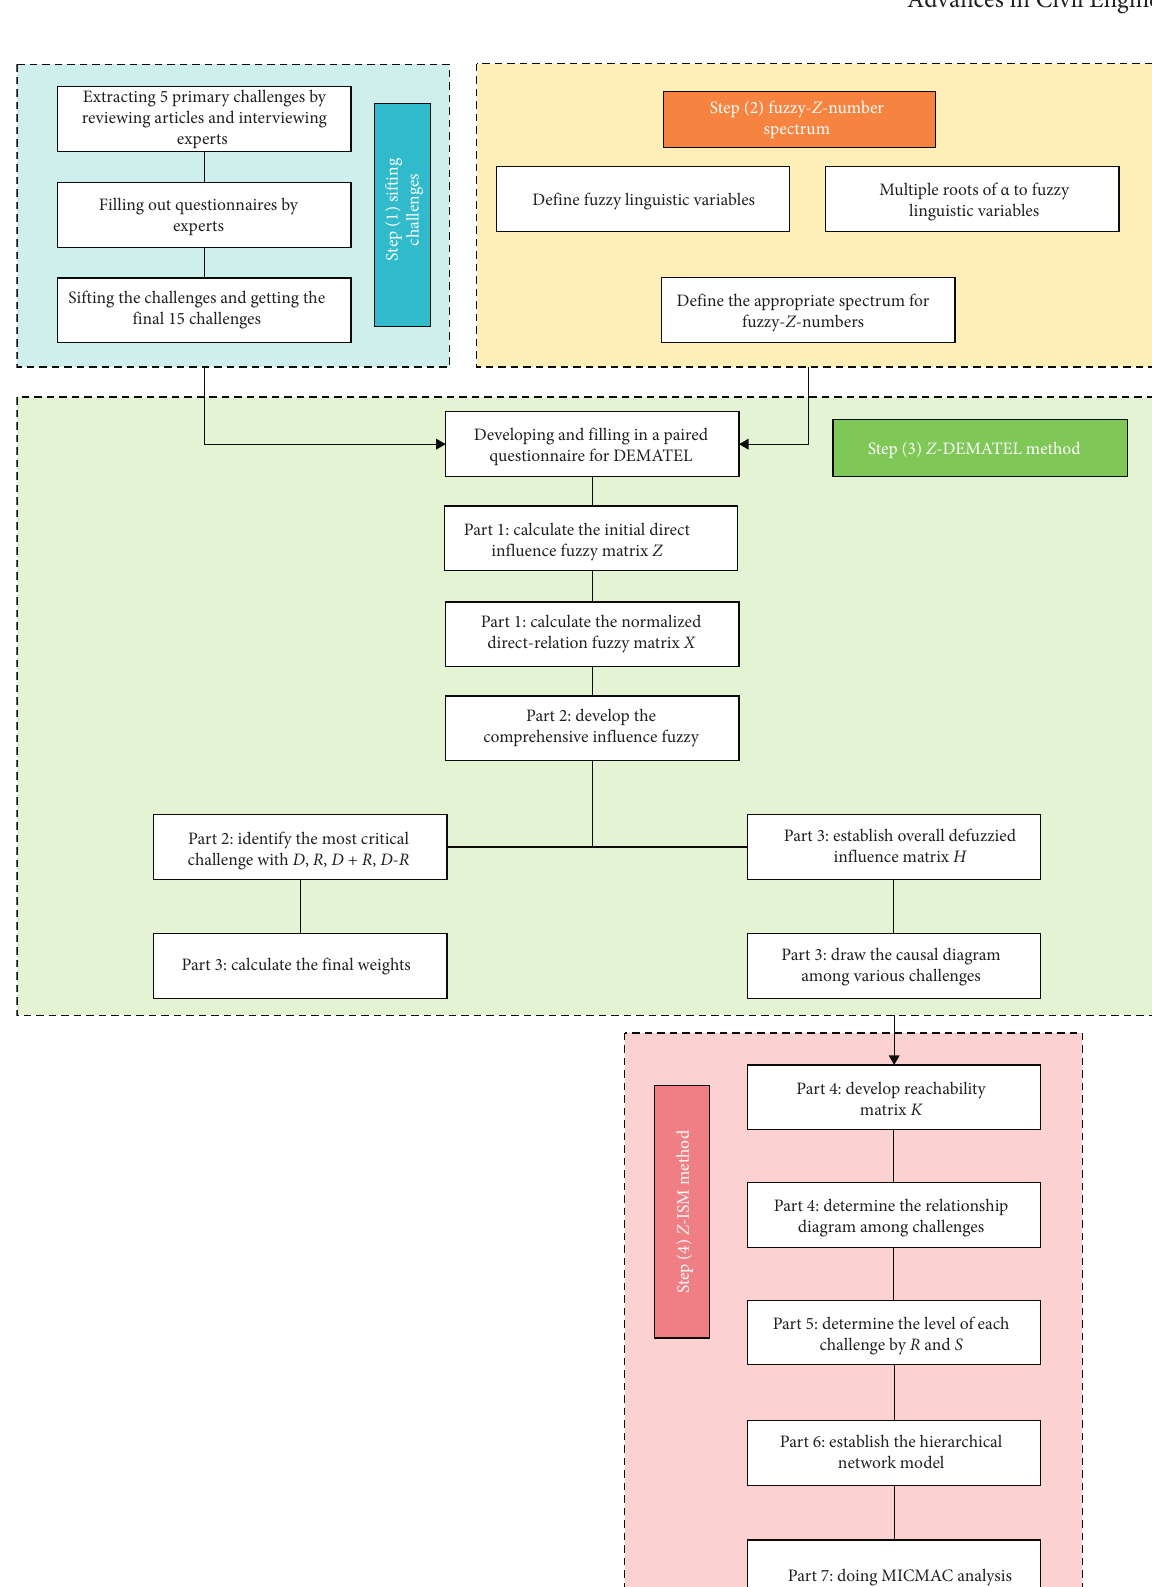
Figure 2: Framework of the